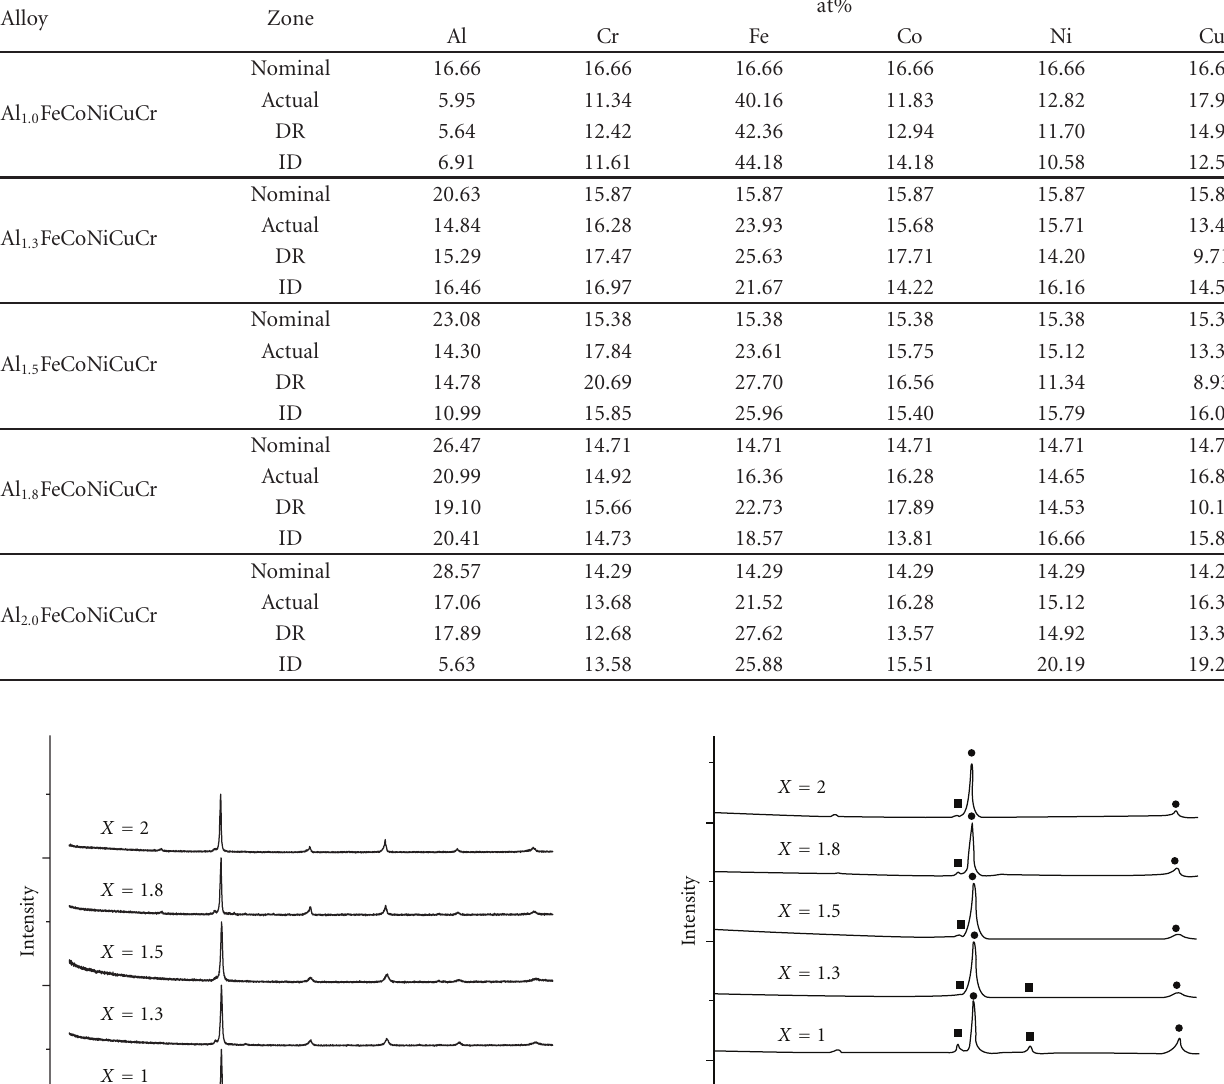
Table 1: The atomic composition and distribution in di ff erent X values.